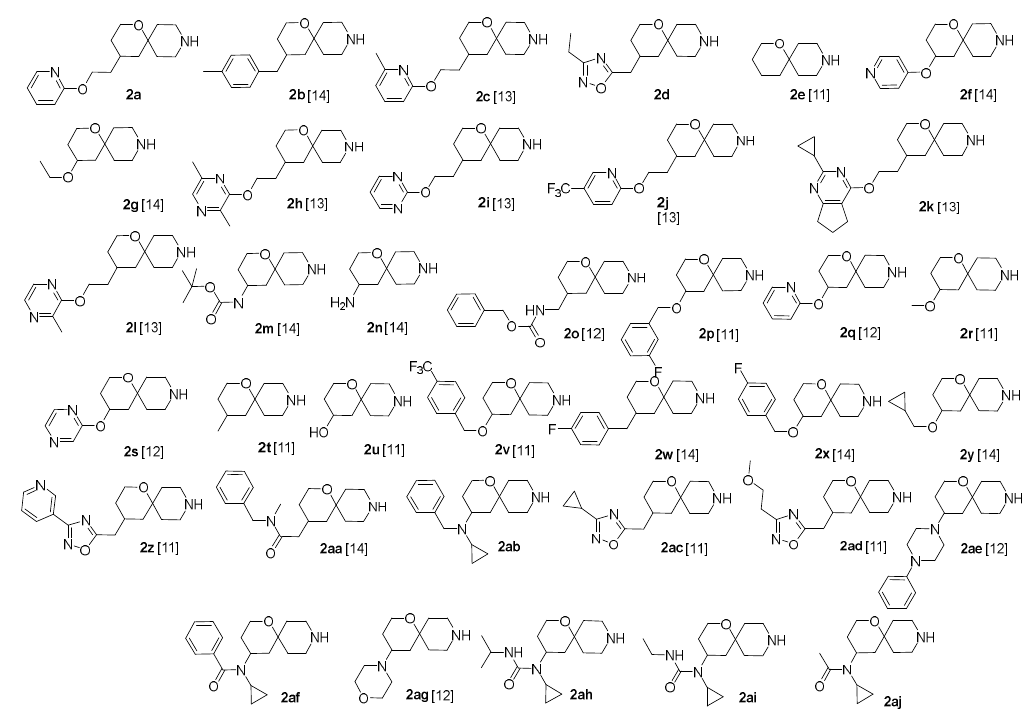
Figure 2. Spirocyclic piperidines 2a–aj employed in this